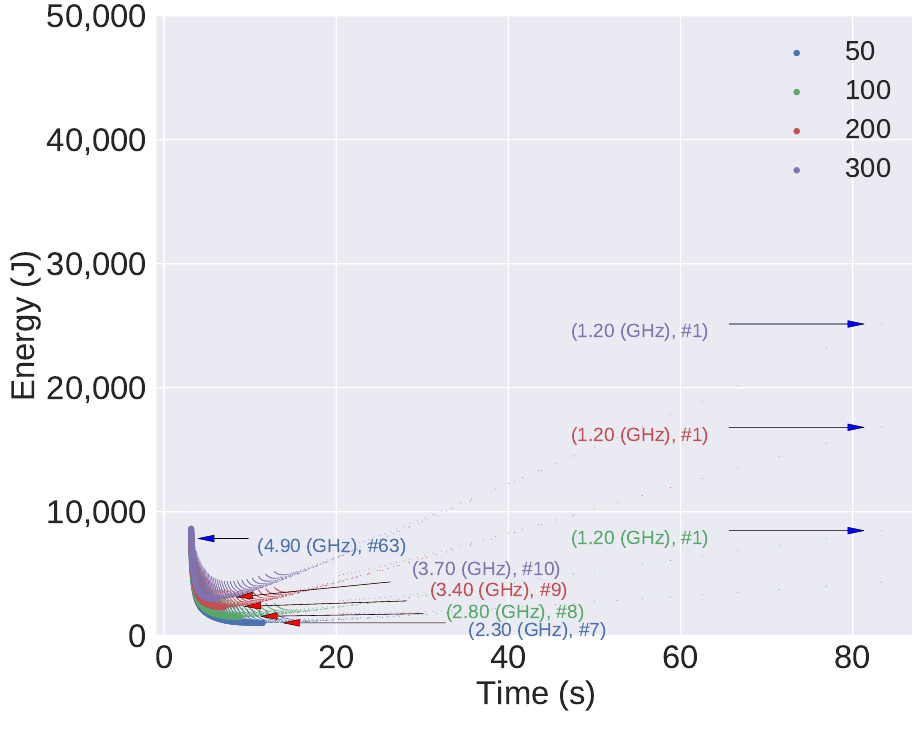
Figure 12. Pareto frontier for several values of static power parameter. The arrows with blue heads indicate the maximum energy, while the arrows with a red head the minimal energy for each corresponding